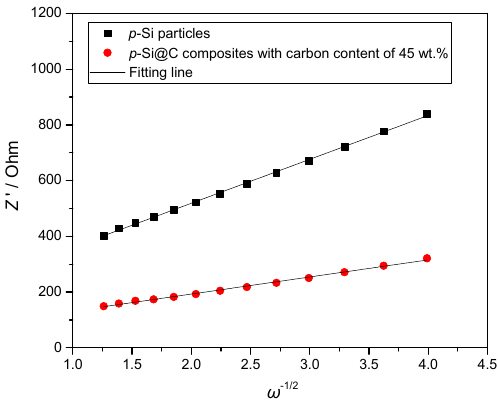
Figure 8. Z ’ plots against ω − 1/2 at the low frequency region of EIS (electrochemical impedance spectroscopy). Figure 8. Z ’ plots against ω -1/2 at the low frequency region of EIS ( electrochemical impedance Table 1. Equivalent circuit parameters obtained from the results of Figures 7 and spectroscopy ). Figure 8. Z ’ plots against ω -1/2 at the low frequency region of EIS ( electrochemical impedance spectroscopy ).